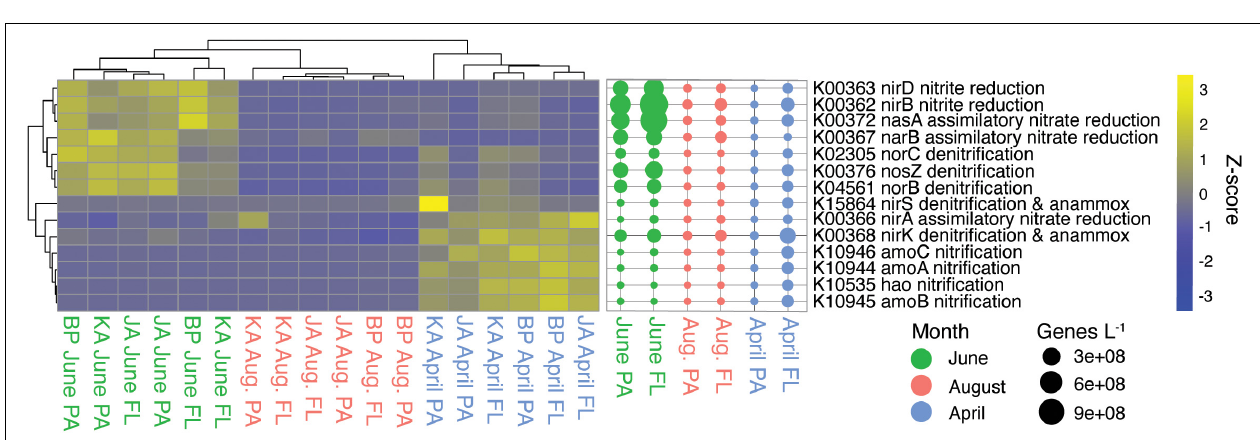
FIGURE 4 | Number of indicator genes for each month grouped by KEGG pathways. Pathways that included more than 10 indicator genes for all 3 months are shown.